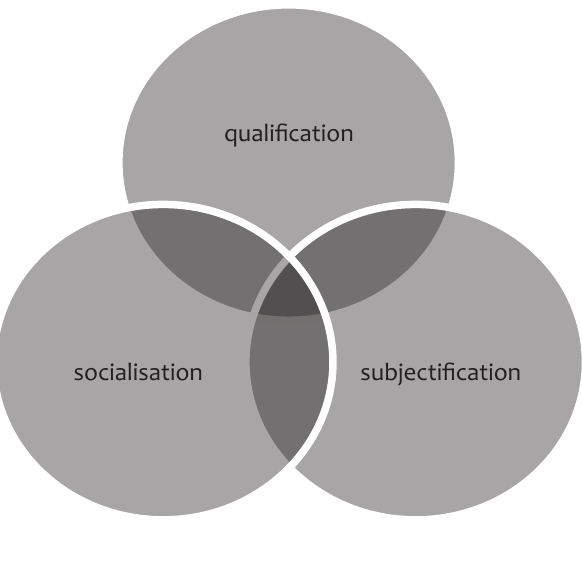
Figure 1: Gert Biesta’s three aims of education